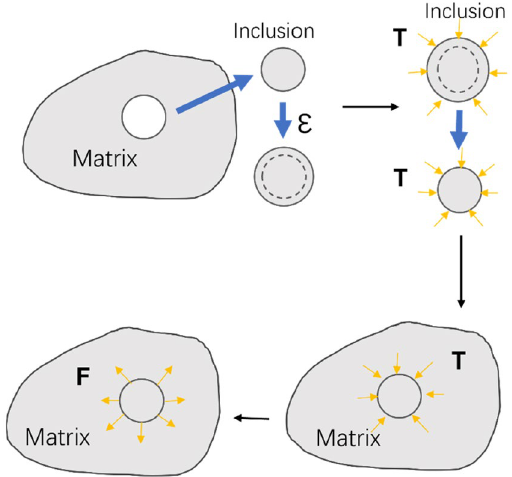
Figure 3. Schematic diagram of Eshelby’s inclusion utilised in our